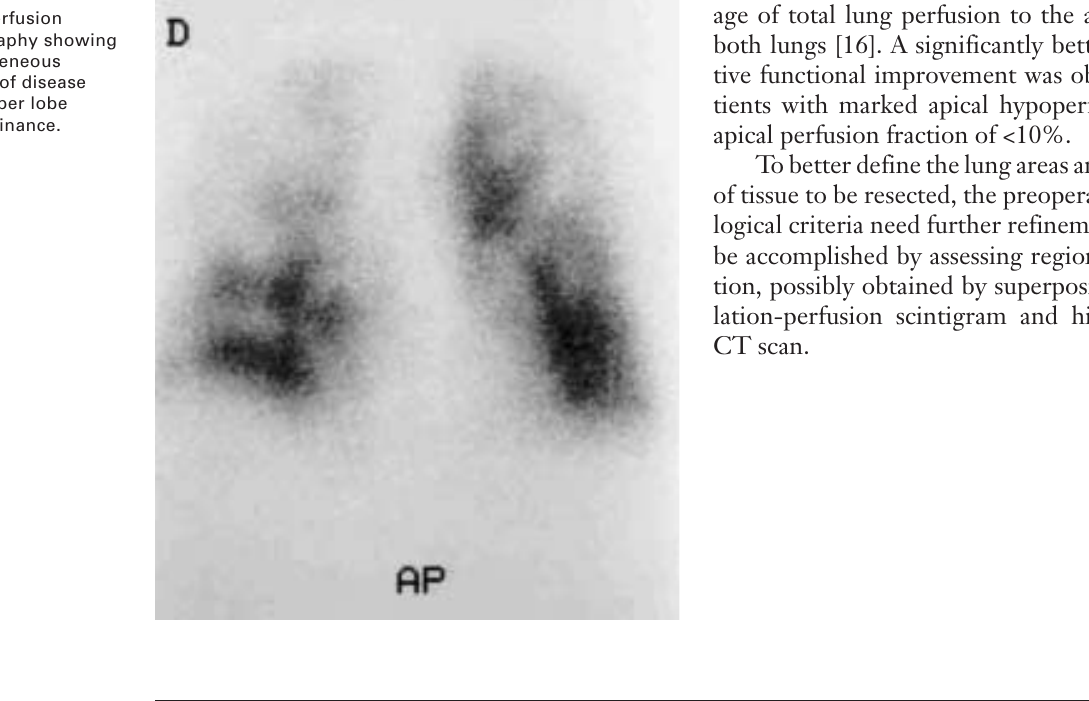
Figure 1 Lung perfusion scintigraphy showing heterogeneous pattern of disease with upper lobe predominance.